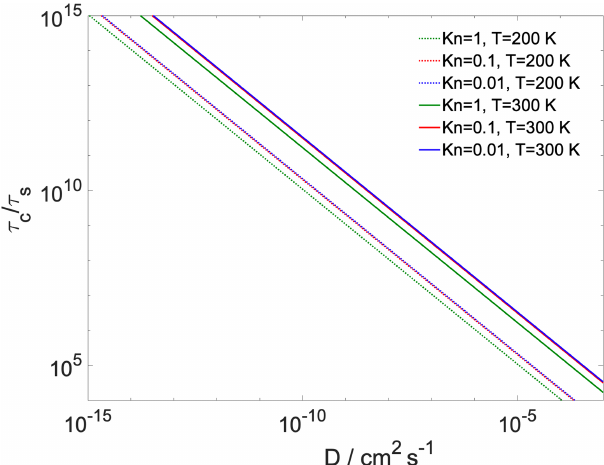
Figure 5. The ratio of characteristic timescales of shell-to-core and gas-to-particle partitioning as a function of bulk-phase diffusivity of the water in the organic shell at varying gas-phase Knudsen num- bers and temperature. At 300K model calculations are presented using both the lower and the upper of the core uptake